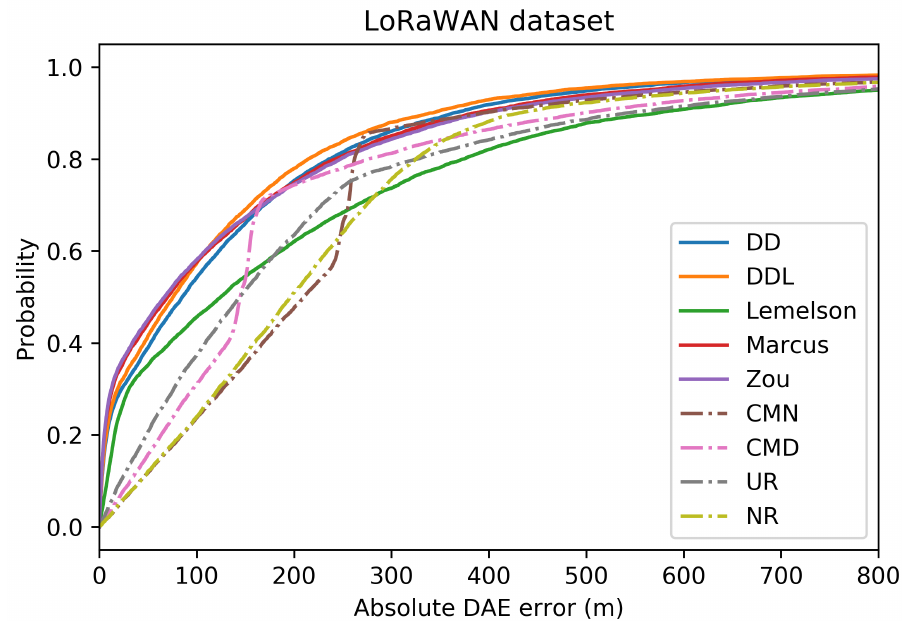
Figure 10. The Cumulative Distribution Function (CDF) of the absolute DAE error (in meters), for all the studied methods and baselines, in the validation set of the LoRaWAN